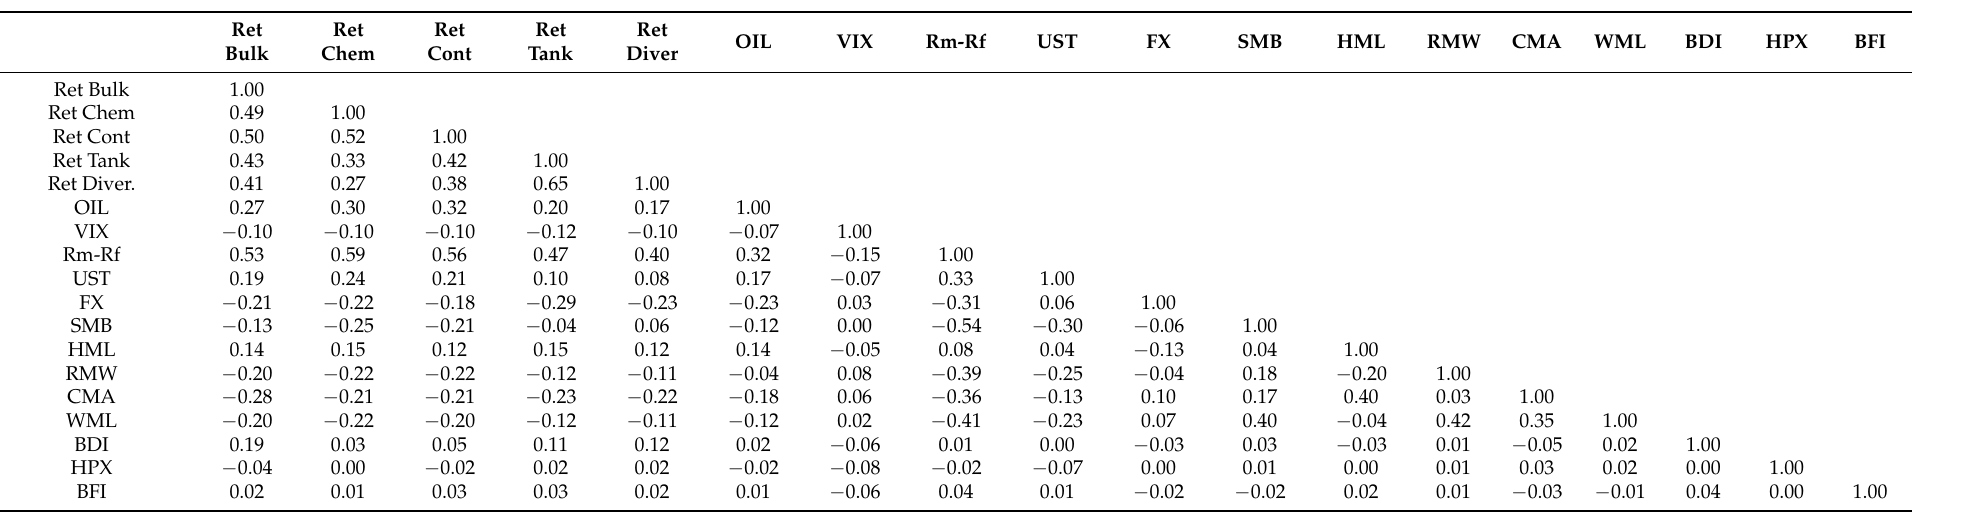
Table 2. Correlation between dependent and explanatory